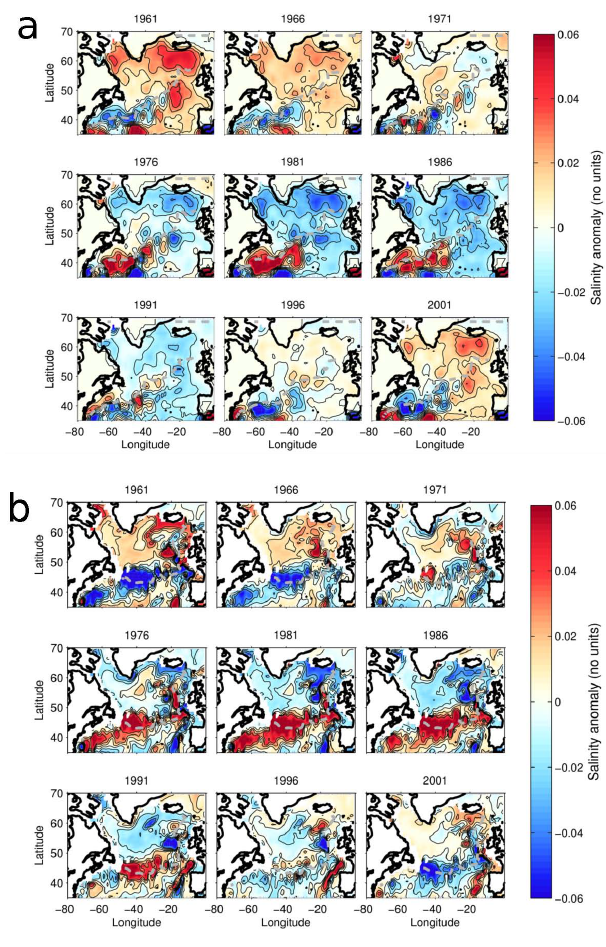
Fig. 3. Low-pass filtered observed (a) and simulated (b) salinity anomalies (referred to the 1958–2006 mean) at 500m depth for var- ious time lags around 1981 (central panel in each figure), the year in which the SPF in the NFB reaches maximum northern latitude. The observations have been filtered spatially with a boxcar window (5 ◦ in the zonal direction and 3 ◦ in the meridional one). The colour bars indicate the magnitude of the anomalies. The grey dashed curves show the position of the SPF for each year.